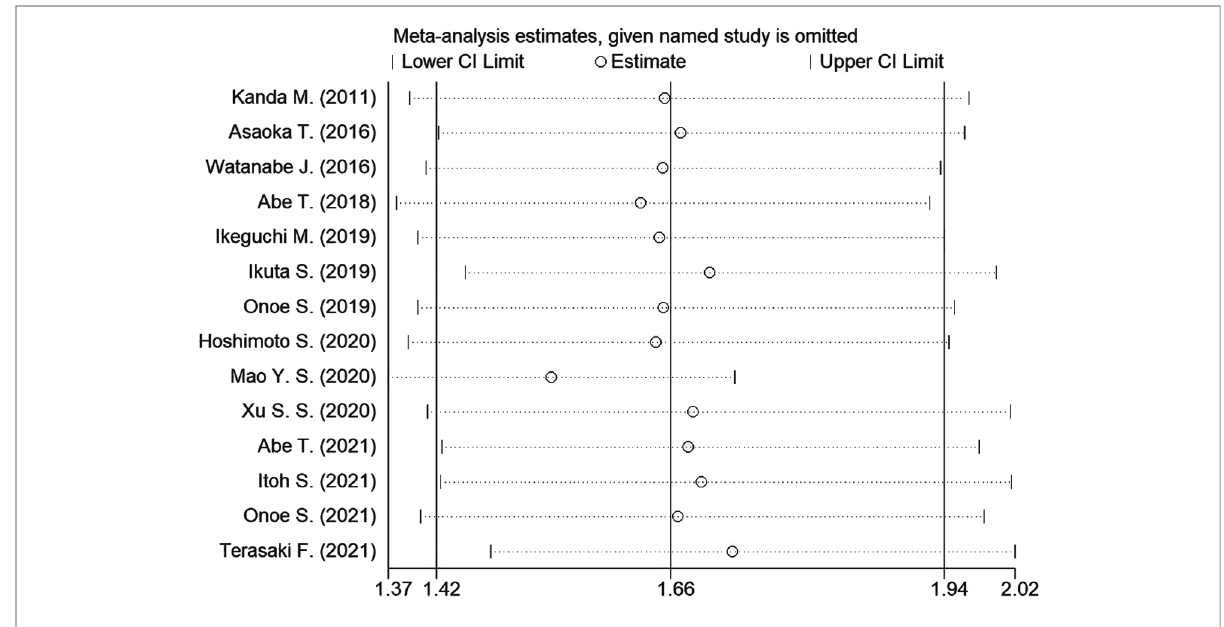
FIGURE 4 Sensitivity analysis of the relationship between PNI and OS. (OS, overall survival).